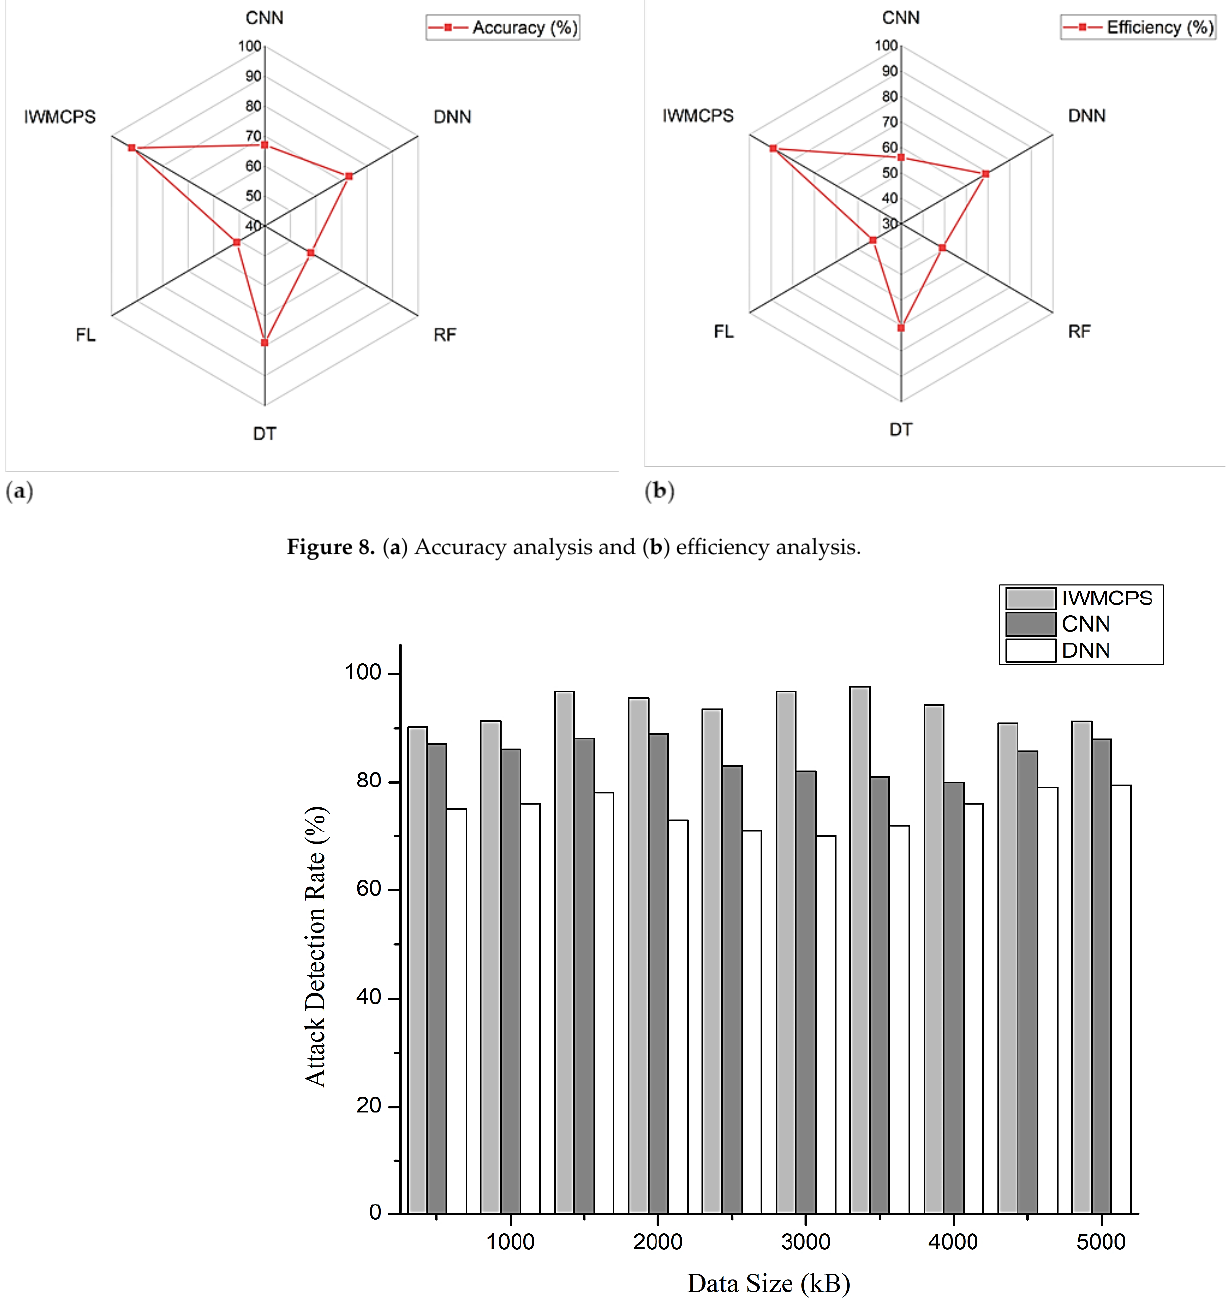
Figure 9. Attack detection rate of IWMCPS.